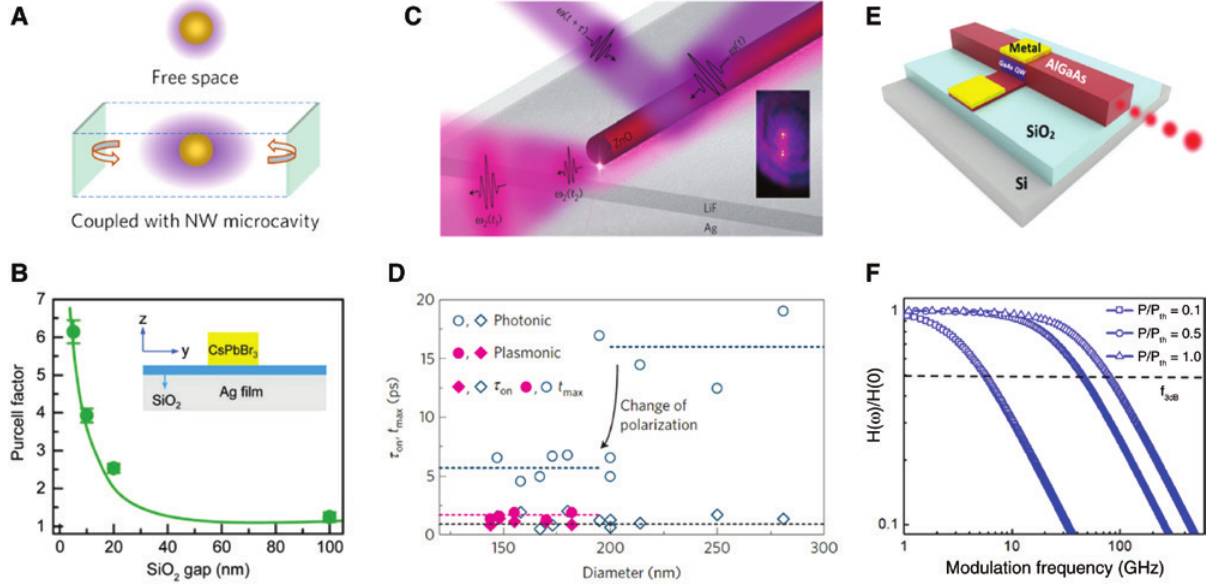
Figure 5: High-speed modulation of plasmonic NW lasers. (A) Schematic of the Purcell effect in the NW nanocavity. (B) Purcell factor as a function of SiO thickness for the CsPbBr NW/SiO /Ag 2 3 2 devices. Inset: schematic of the plasmonic nanolaser. Reproduced with permission [161]. Copyright 2018, Wiley-VCH. (C) Schematic of the plasmonic laser based on ZnO NW/LiF/Ag optically excited with two time-delayed pump pulses. Inset: optical image of a lasing plasmonic NW. (D) Characteristic temporal parameters τ (diamonds) and t (circles) for the same plasmonic (closed symbols) and photonic (open on max symbols) NWs. Reproduced with permission [190]. Copyright 2014, Springer Nature. (E) Schematic of inline plasmonic cavity-based nanolaser. (F) Modulation bandwidth of the inline cavity nanolaser/LED at different pump rates. Reproduced with permission [191]. Copyright 2016, American Chemical